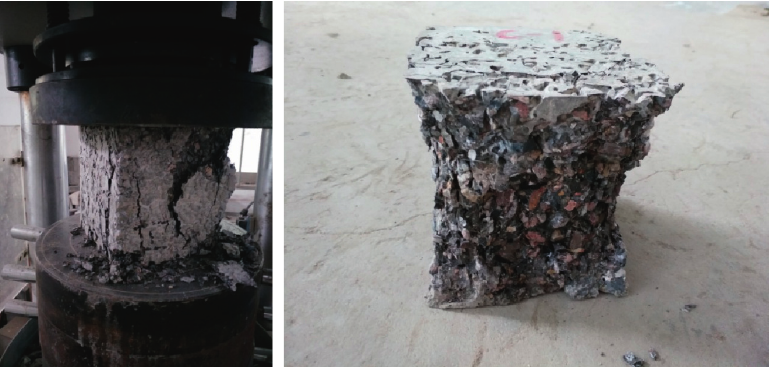
Figure 6: Damage pattern of RAPC under uniaxial